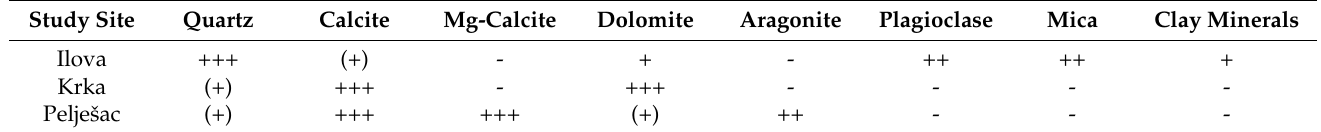
Table 5. Summarized mineral composition for all study sites and both fish farms and reference sites. Selected diffractograms are presented in the Supplementary Materials, Figures S1–S6.